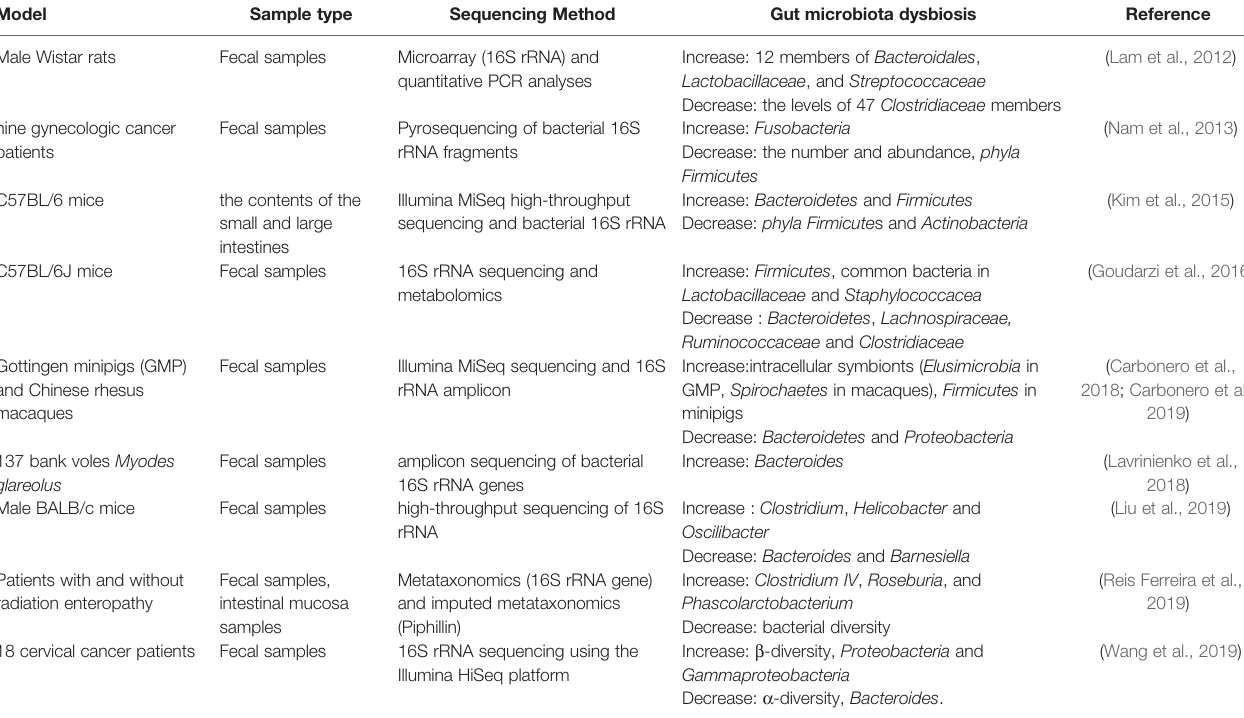
TABLE 1 | Radiotherapy causes gut microbiota